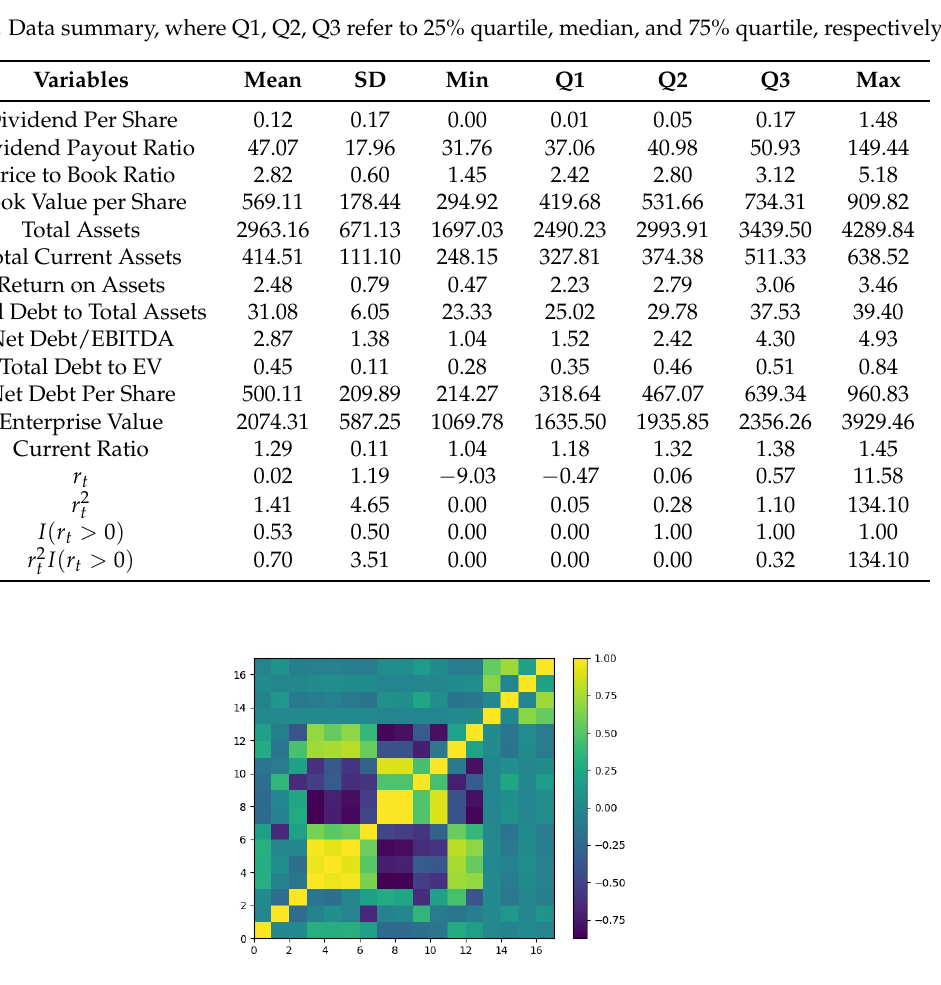
Figure 2. Heat map of the correlation matrix of data after normalization. The colors indicate the magnitudes of the